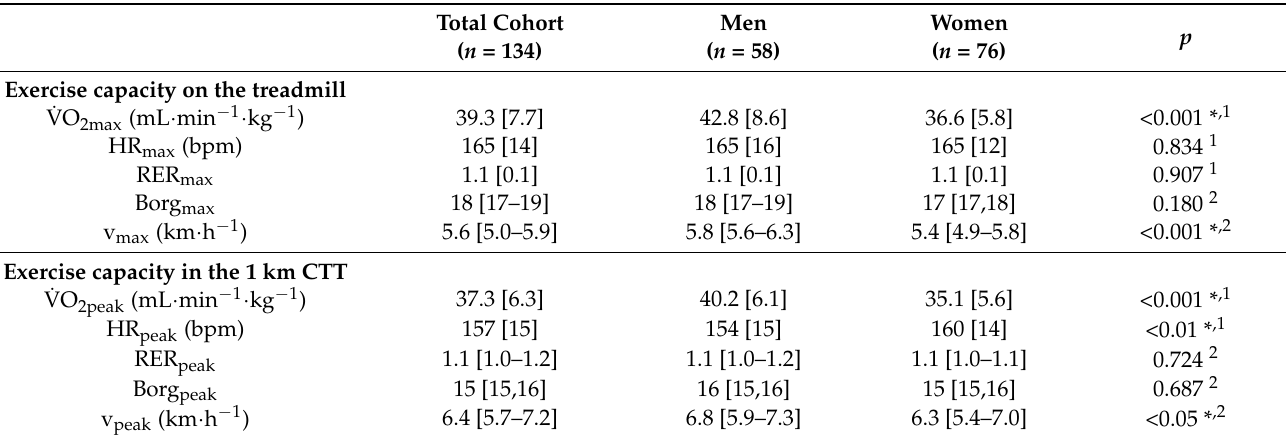
Table 4. Performance parameters during the maximal laboratory testing on the treadmill and the submaximal 1 km field